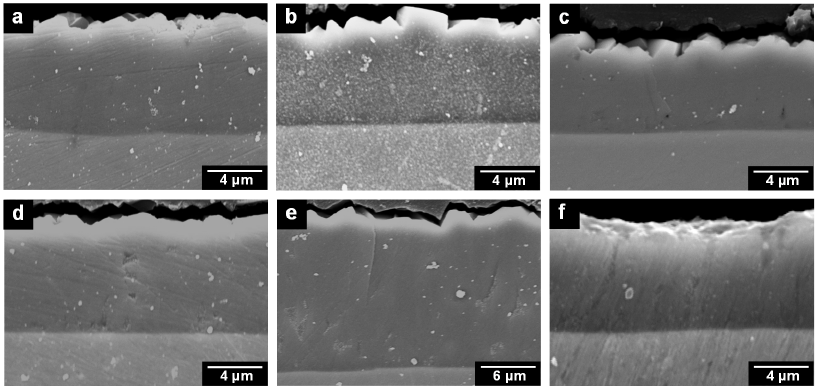
Figure 6. SEM images of the cross section of magnetite films on carbon steel substrates with different roughnesses and agitation speeds at the − 1.05 V SCE in Fe(III)–TEA solution at 80 °C: ( a ) #80 grit, ( b ) #220 grit, ( c ) #600 grit, ( d ) #2000 grit, ( e ) #600 grit + stirring 900 rpm, and ( f ) #600 grit + stirring 900 rpm (deposition time: 700 s).